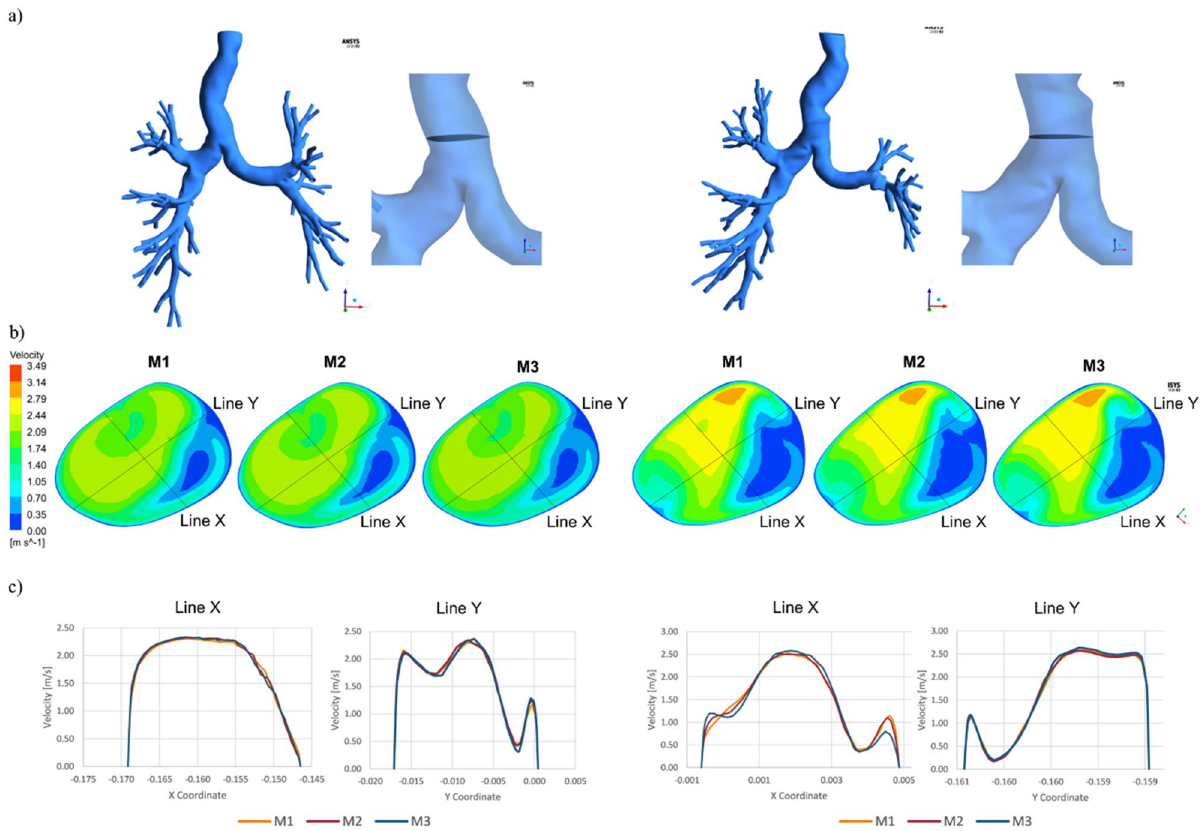
Figure 1. Mesh convergence analysis for a representative left upper pulmonary lobectomy subject (subject 9) in the pre-operative (left) and the post-operative (right) models. In the pre-operative models, for this representative patient, the number of elements for M1, M2, M3 of was equal to 3.7 × 10 6 , 6.3 × 10 6 , 10.0 × 10 7 , respectively. For the post-operative models M1, M2, M3 were characterized by 3.2 × 10 6 , 5.8 × 10 6 , 9.9 × 10 6 elements, respectively. ( a ) position of the plate inside the bronchial tree. ( b ) contours of velocity on the plate for M1, M2, M3 in the pre (left) and post-operative (right) models. ( c ) Velocity profiles along lines X and Y for the pre (left) and post-operative (right) cases (Fluent v16, CFD-Post v16-Ansys, www. ansys.